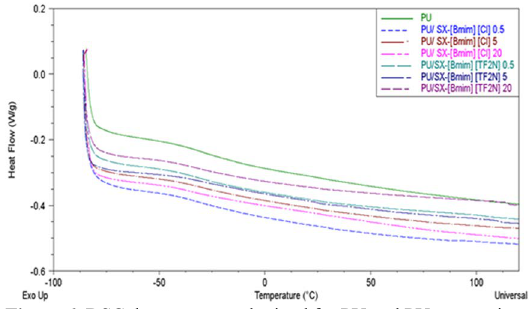
Figure 6. DSC thermograms obtained for PU and PU composites.